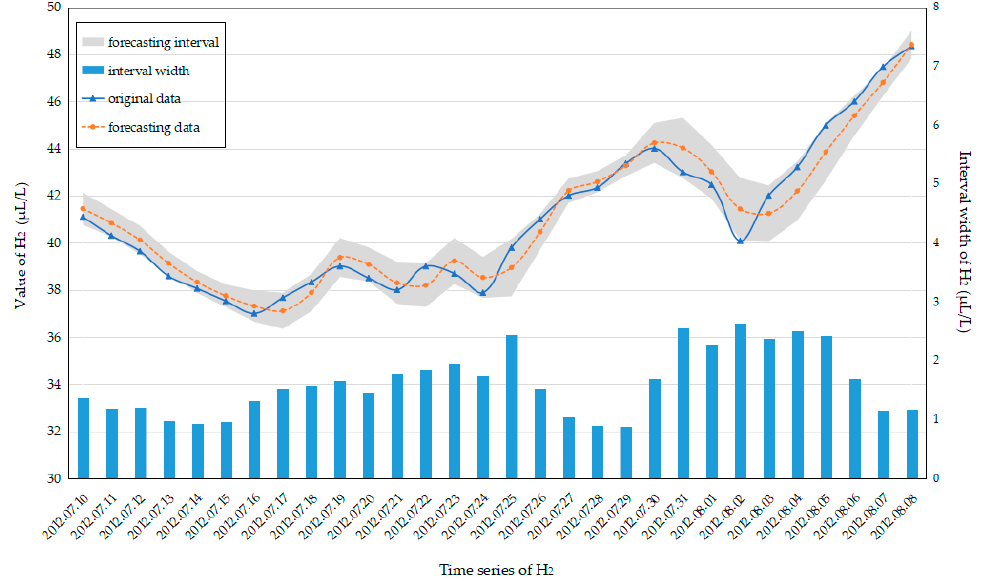
Figure 5. Interval forecasting result of time series of H 2 from 10 July 2012 to 8 August 2012.